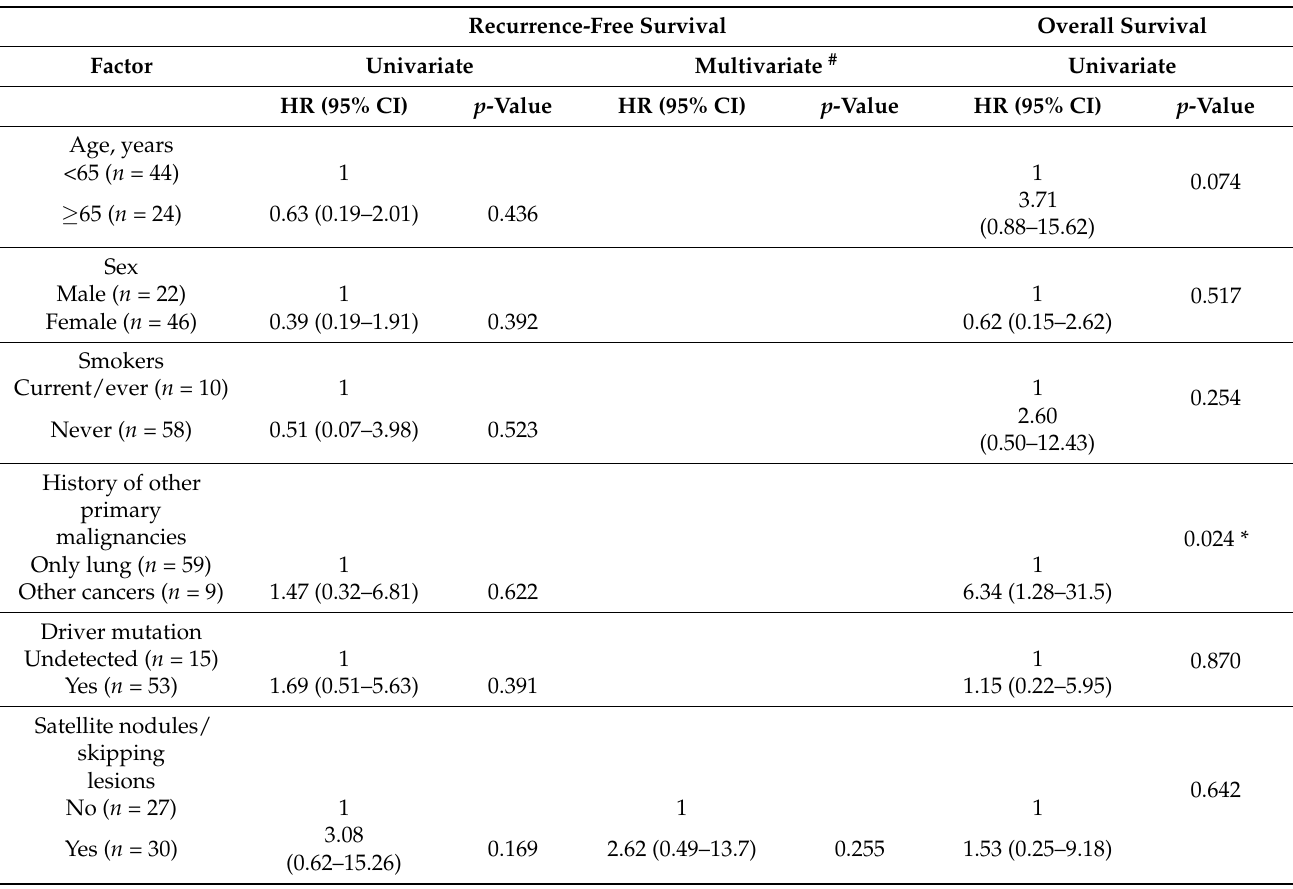
Table 3. Clinicopathological analyses of recurrence-free survival (RFS) and overall survival (OS) in stage I–IIIA pulmonary invasive mucinous adenocarcinoma. Recurrence-Free Survival Overall Survival Univariate Multivariate